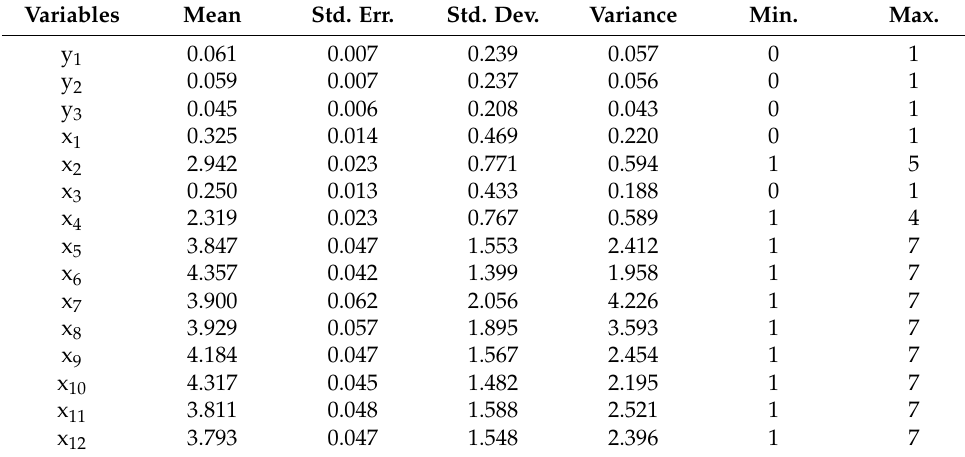
Table 5. Descriptive statistics of